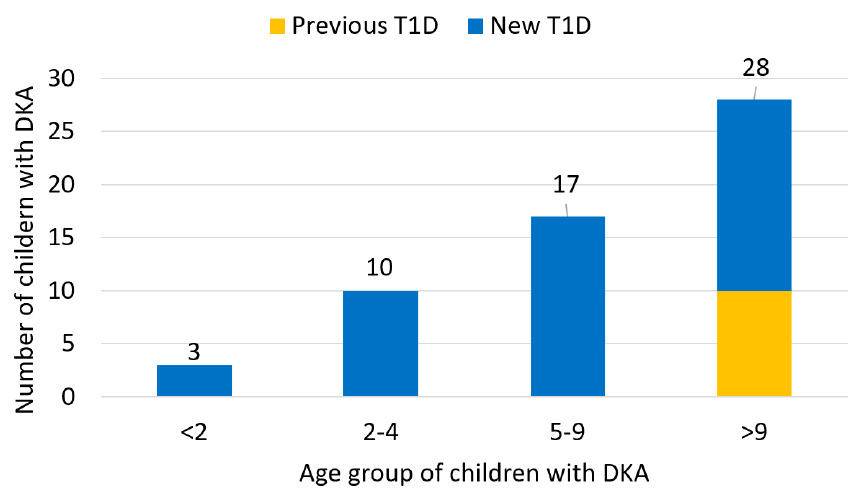
Figure 2. Number of children with diabetic ketoacidosis admitted in Pediatric Intensive Care Unit in the period 2011–2020, divided by age groups.Legend: T1D—type 1 diabetes; DKA—diabetic ketoacidosis. Legend: a diabetic ketoacidosis; b type 1 diabetes; c type 2 diabetes; d standard deviation; e serum bicarbonate; f partial carbon dioxide pressure; g base excess; h glycated hemoglobin; i sodium; j potassium; k blood urea nitrogen. Data are n (%), mean ± standard deviation as appropriate.